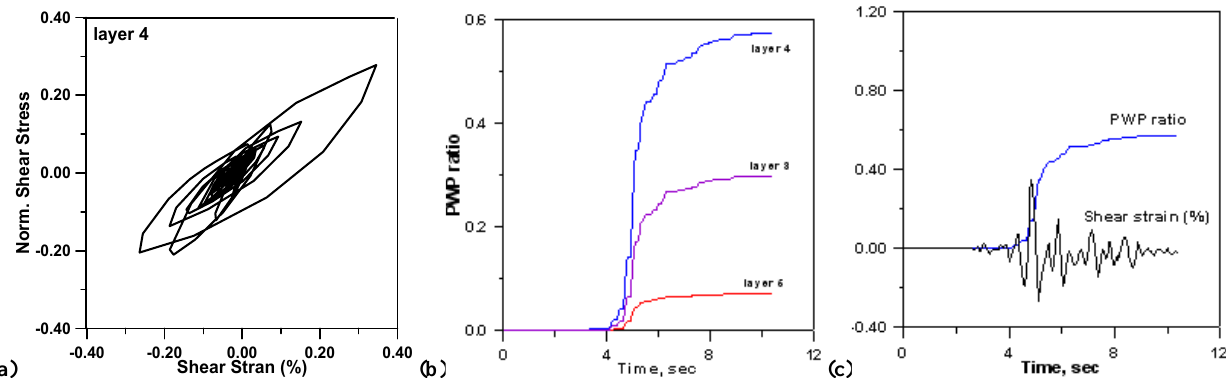
Figure 22 Fig. 22. Stress-strain history (a) for the layer with high probability to liquefy; PWP time histories at different ground level (b) ; PWP and shear strain time histories (c) for the layer with high probability to liquefy.